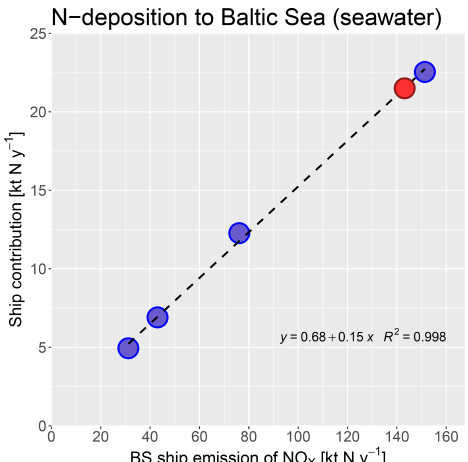
Figure 12. Relationship between emissions of NO x (in ktNyr − 1 ) from the Baltic Sea ship fleet and the annual ship-related nitrogen deposition (in ktNyr − 1 ) to the Baltic seawater (on spatial average) based on the model results of the present-day simulation and the model results of the future scenario simulations. Red-filled circle indicates the ship contribution in scenario SSP3 predicted from the linear fit to the